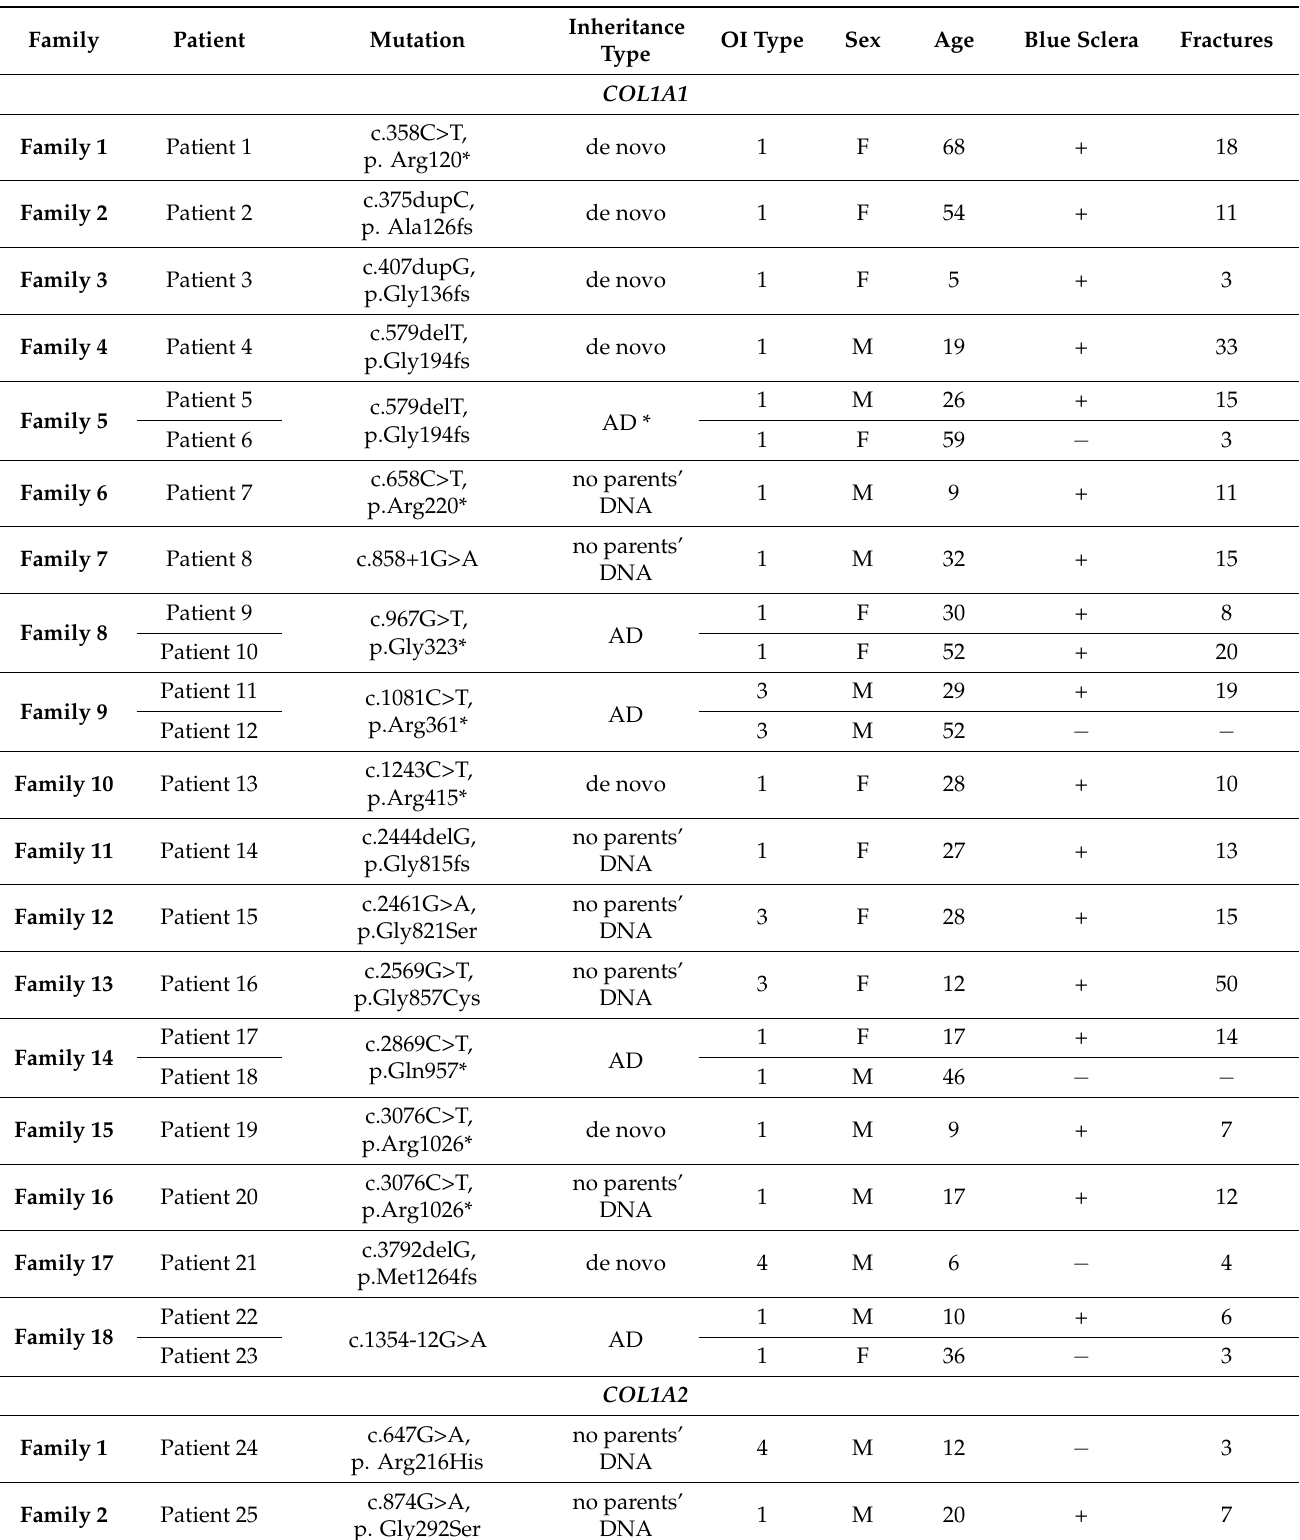
Table 1. Clinical characteristics of patients with mutations in type I collagen